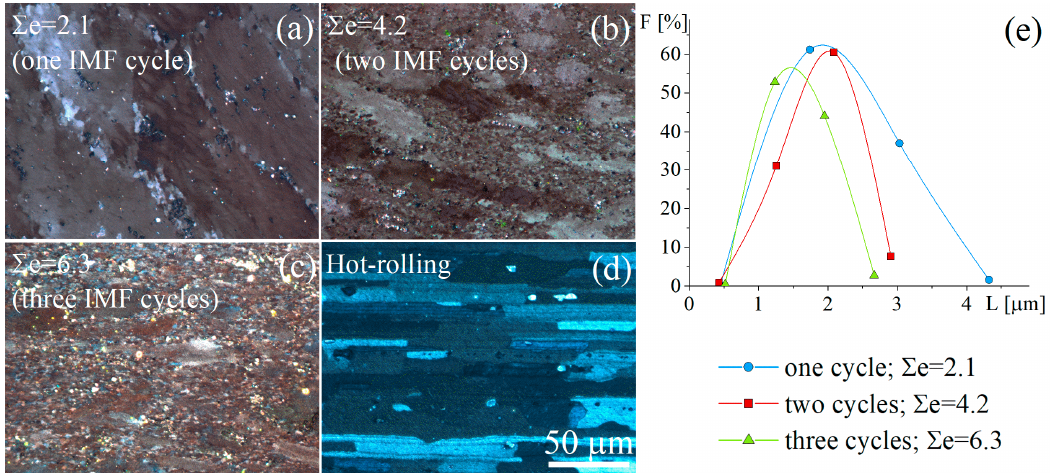
Figure 4. The grain structure in the center part of the sample ( a – c ) isothermal multidirectional forging at 350 °C at various cumulative strains: ( a ) 2.1, ( b ) 4.2, and ( c ) 6.3; ( d ) grain structure after hot rolling with a strain of 2.14; polarized light, optical microscope, ( e ) grain size distribution.